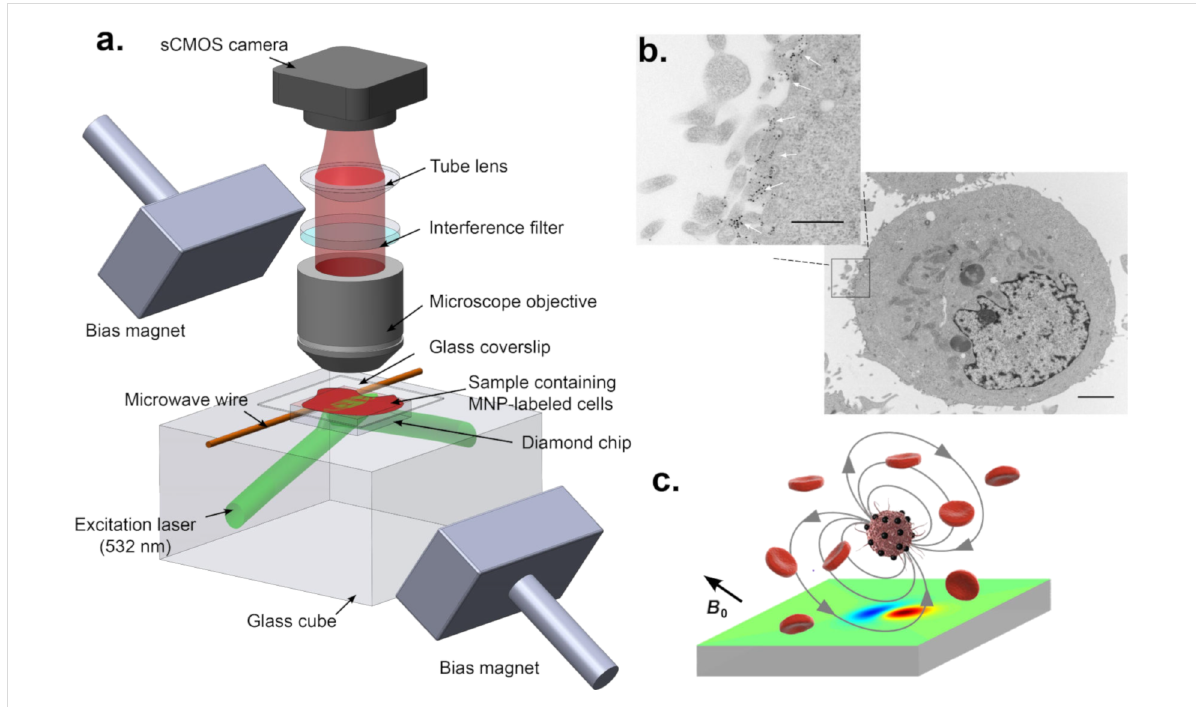
Figure 3: Single-cell magnetic imaging quantum diamond microscope [53]. Image reprinted with permission from [53], copyright 2015, Springer Nature Publishing. (a) Wide-field magnetic imaging microscope based on NV centers in diamond. Immunomagnetically labeled cells are positioned on top of a diamond with a surface layer of NV centers. A 532 nm laser is used to measure the ODMR of the NV electronic spins. An sCMOS camera is used to image the NV fluorescence. The magnetic field projection along one of the [111] diamond axes is measured over a 1 mm × 0.6 mm field-of- view for each imaging pixel. The scheme is adapted from [30] where further details are provided. (b) Electron micrograph of an SKBR3 cell labeled with MNPs conjugated to HER2 antibodies. The black dots on the cell membrane highlighted by the white arrows in the expanded view indicate the magnetic nanoparticles. The main figure scale bar is 2 μ m. The inset scale bar is 500 nm. (c) MNP-labeled diagram of a target and surroundings with unlabeled normal blood cells. The magnetic bias field B 0 externally applied is aligned with the diamond [111] axis. This field is used to magnetize the MNP labels. These magnetized nanoparticles produce the field then are imaged by the shallow NV center layer that is close to the surface of the diamond surface to show a dipole-like